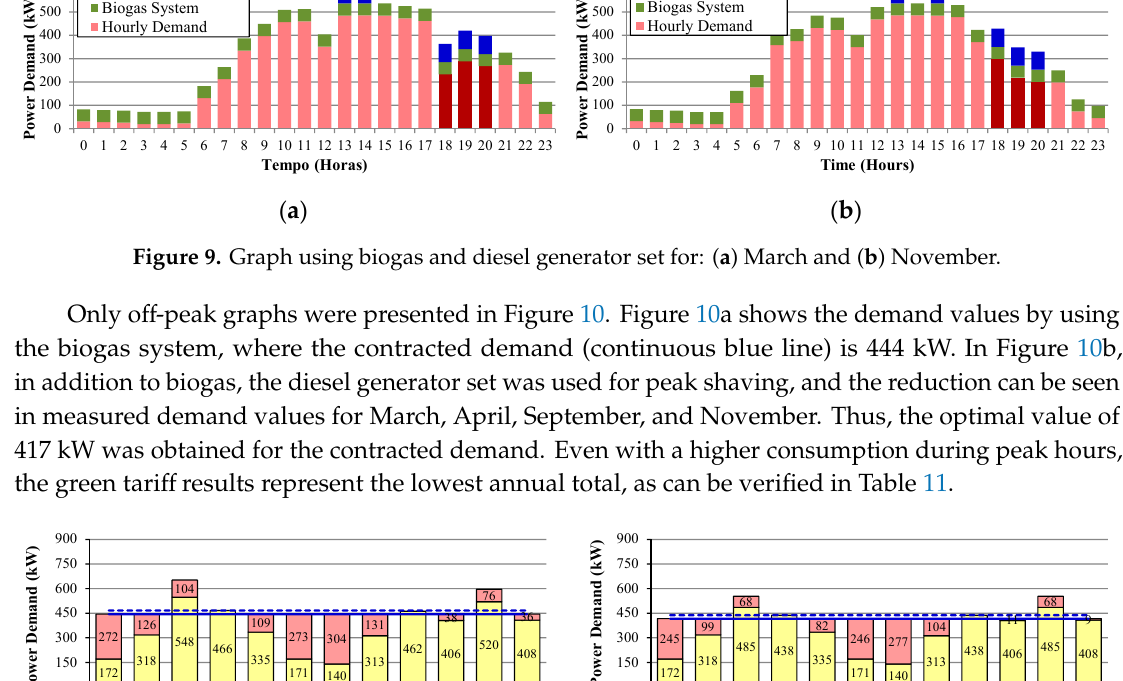
Figure 10. Off-peak demand values for: ( a ) scenario 6 and ( b ) scenario 7. Figure 10. O ff -peak demand values for: ( a ) scenario 6 and ( b ) scenario